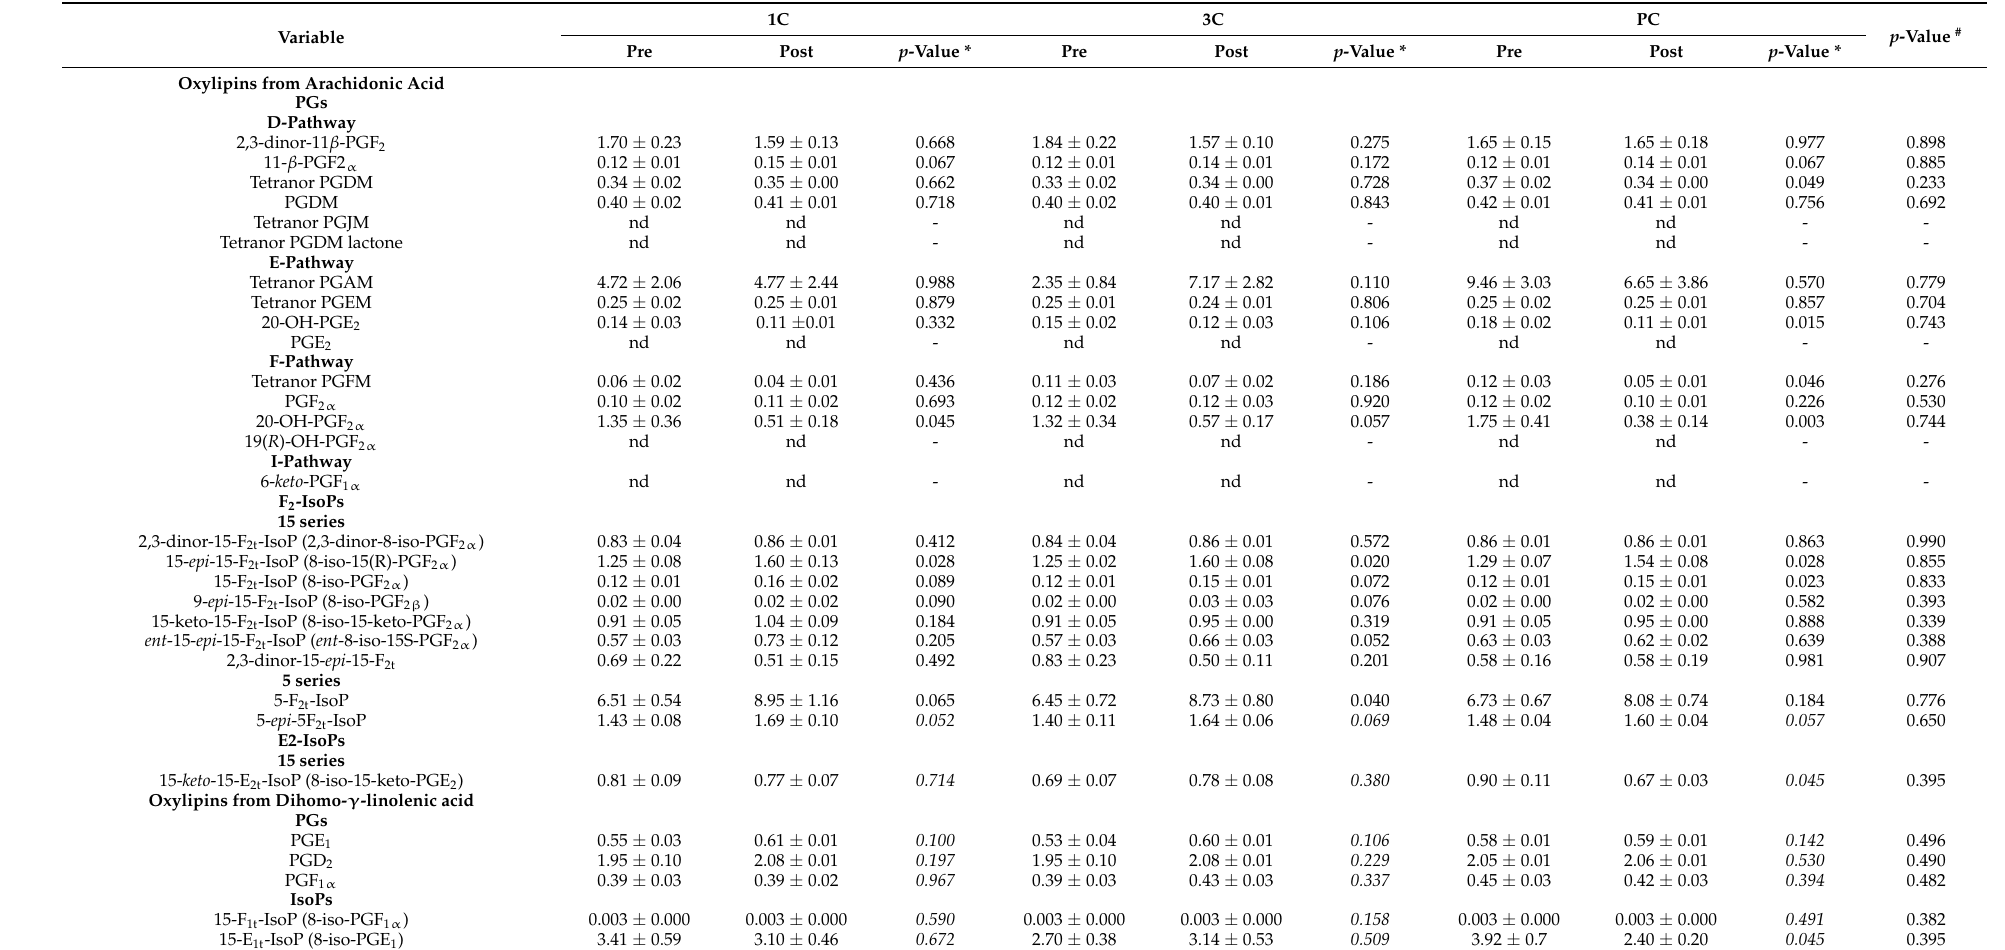
Table 5. Markers of lipid oxidation catabolites after each treatment ( n =